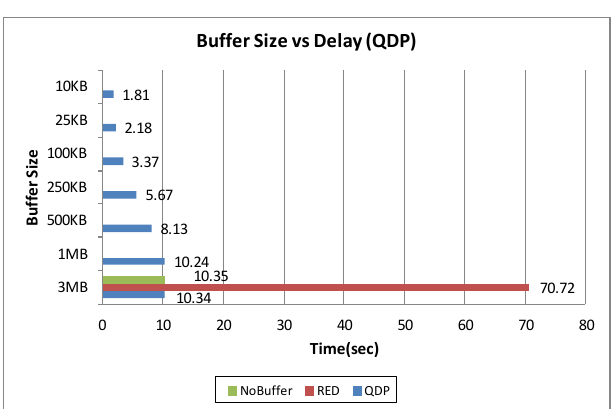
Figure 6. Buffer Size vs.